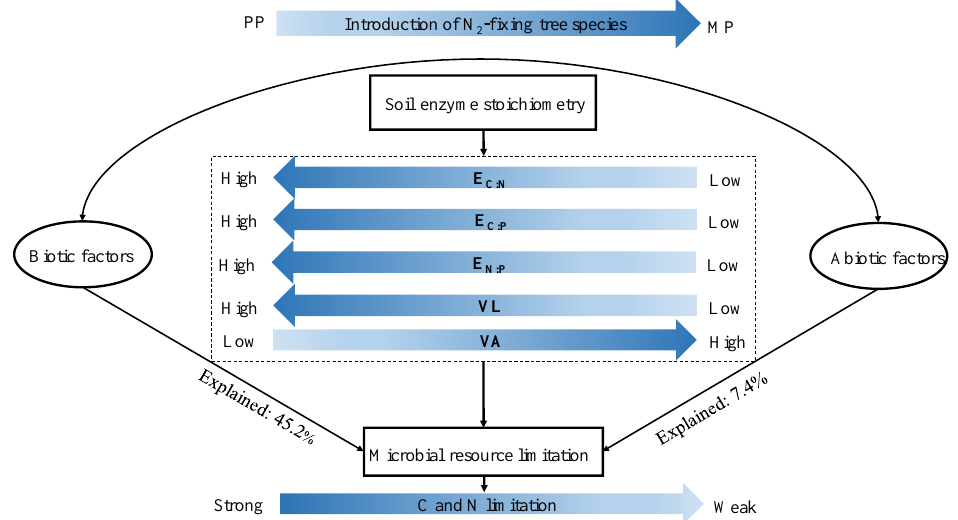
Figure 7. Conceptual map of the resource limitation of soil microbes following introducing N 2 -fixing tree species as revealed by the soil extracellular enzymatic stoichiometry (EES). E C:N , ln(BG + CB):ln(NAG + LAP); E C:P , ln(BG + CB):ln(ACP); E N:P , ln(NAG + LAP):ln(ACP); VL, vector length; VA, vector angle.